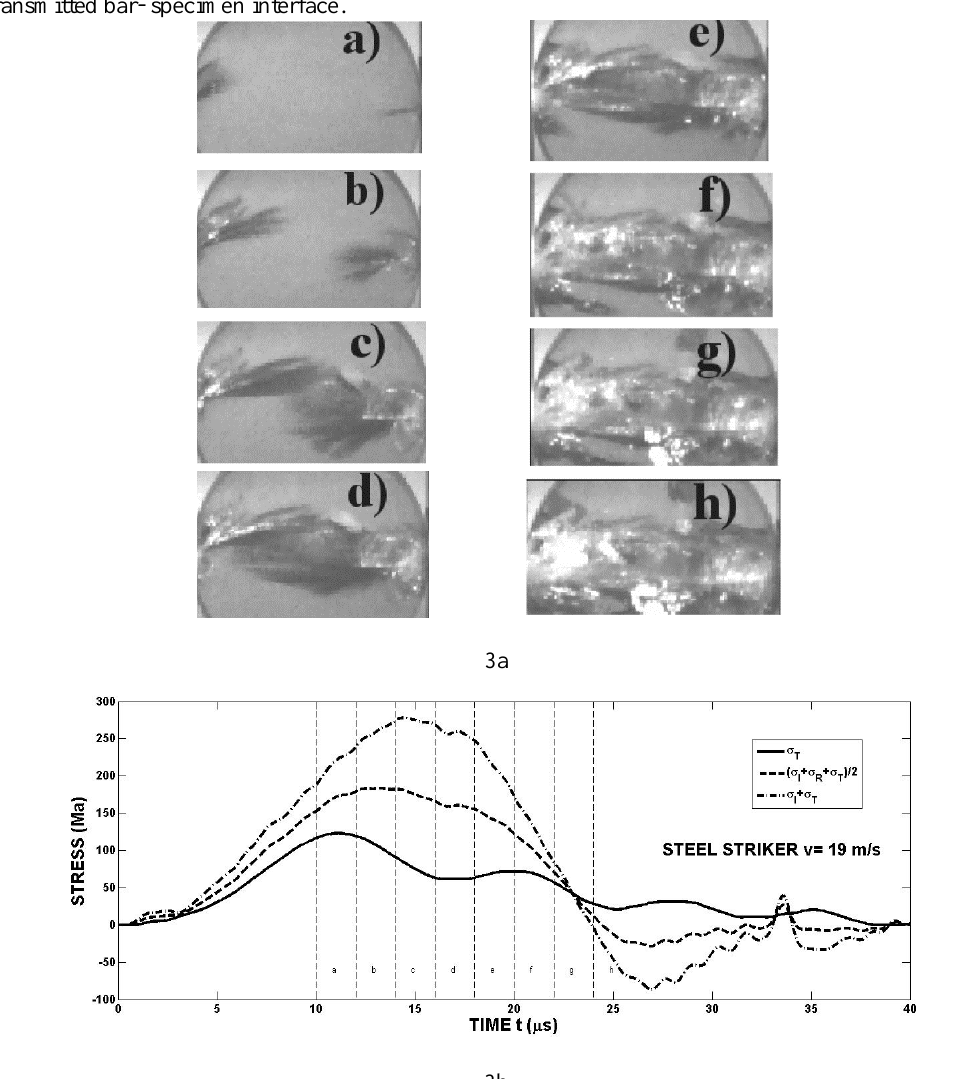
Fig.3 .a- High speed images of failure process in specimen at different times. Steel striker. Striker velocity 19 m/s. b - Stress – time history. Position of single